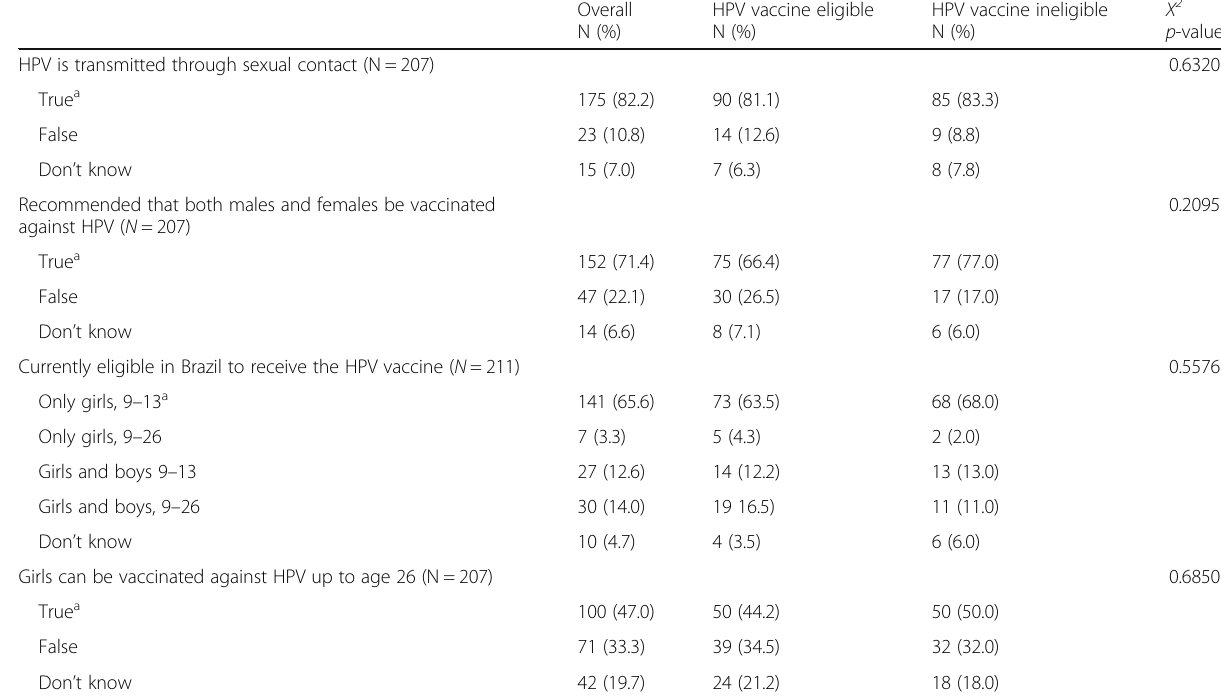
Table 4 Knowledge about HPV, HPV vaccine, transmission, and Brazil ’ s eligible population for vaccination among parents with children between the ages of 9 and 17 in São Paulo, Brazil,